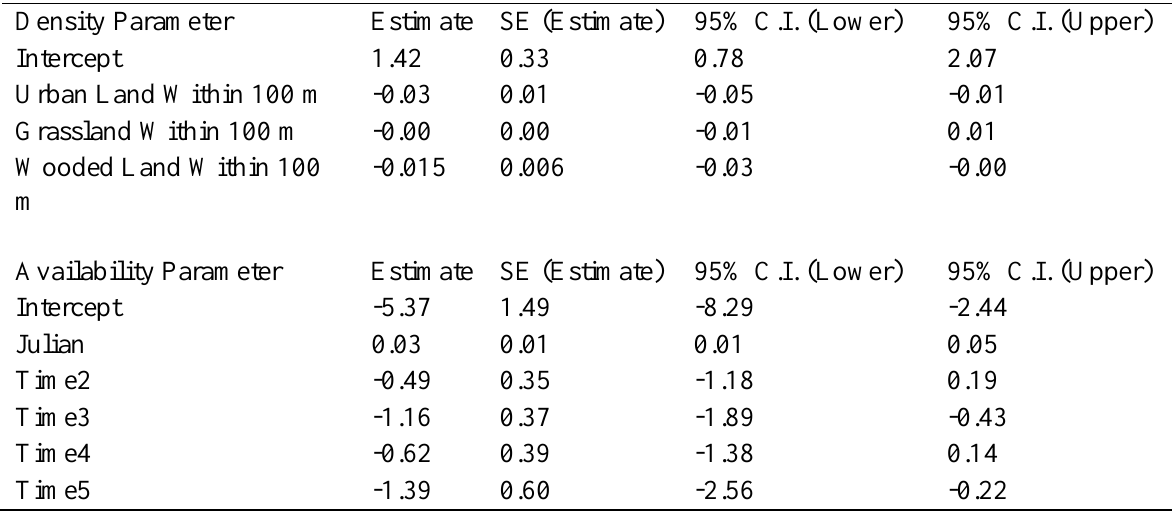
Table A2.F . Second-highest-ranking hierarchical distance-sampling model (AIC ∆ AIC =0.39, AIC weight=0.27) for Clay-coloured Sparrows along 44 transmission line study c sites in Winnipeg, Manitoba, Canada in 2009 (n=132 surveys), assuming a uniform detection probability with increasing distance of birds from the transect line and effects of Julian date and time of morning but not observer experience on availability for